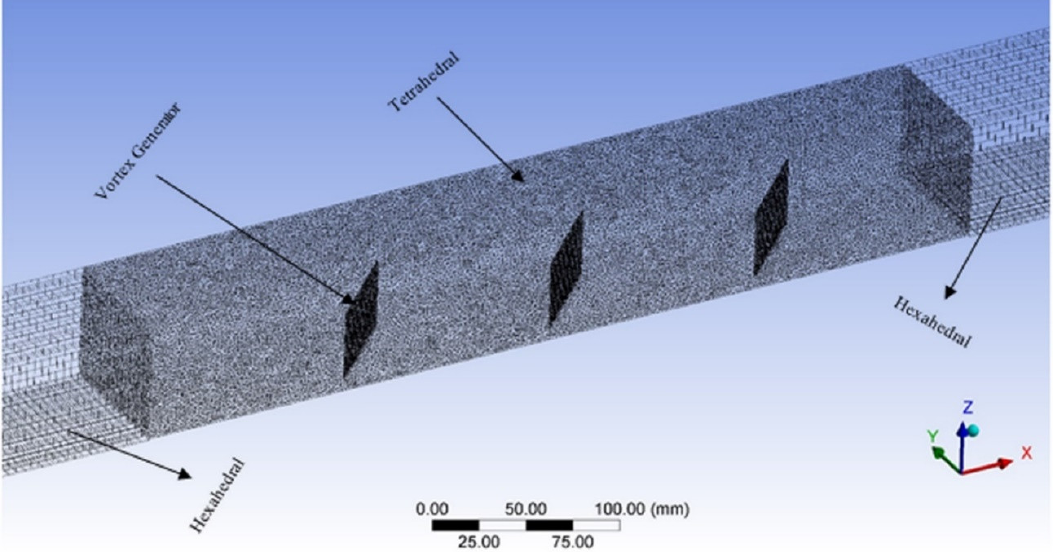
Figure 5. Mesh Generation.